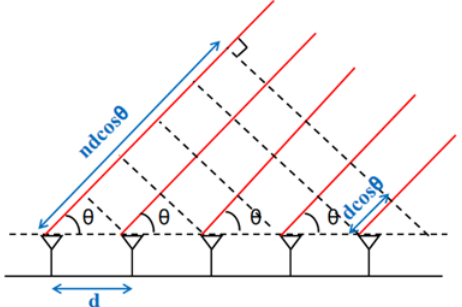
Figure 14. AoA model with the antenna array